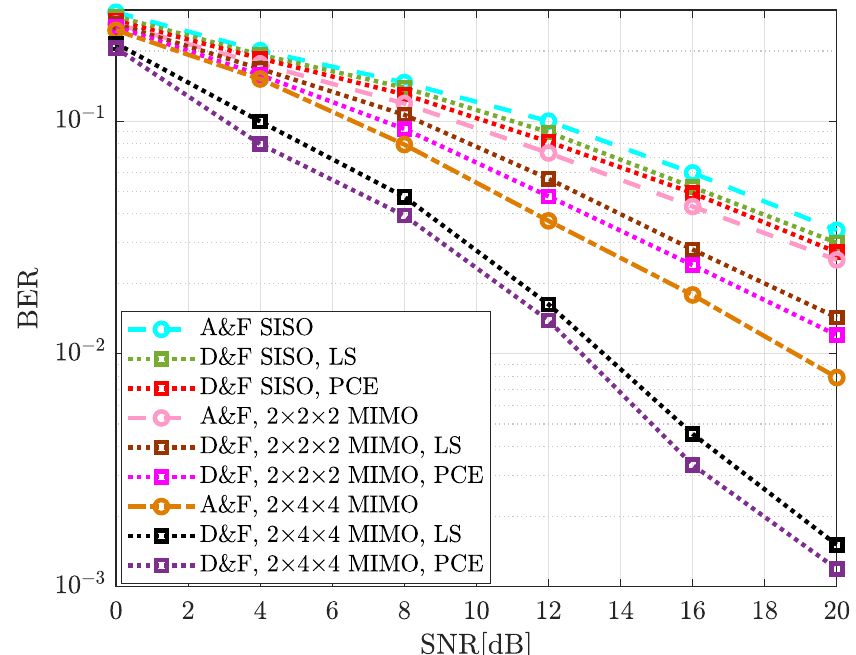
Figure 12. BER comparison for different uplink mmWave NR-RN co-operative schemes implemented with the 256-QAM